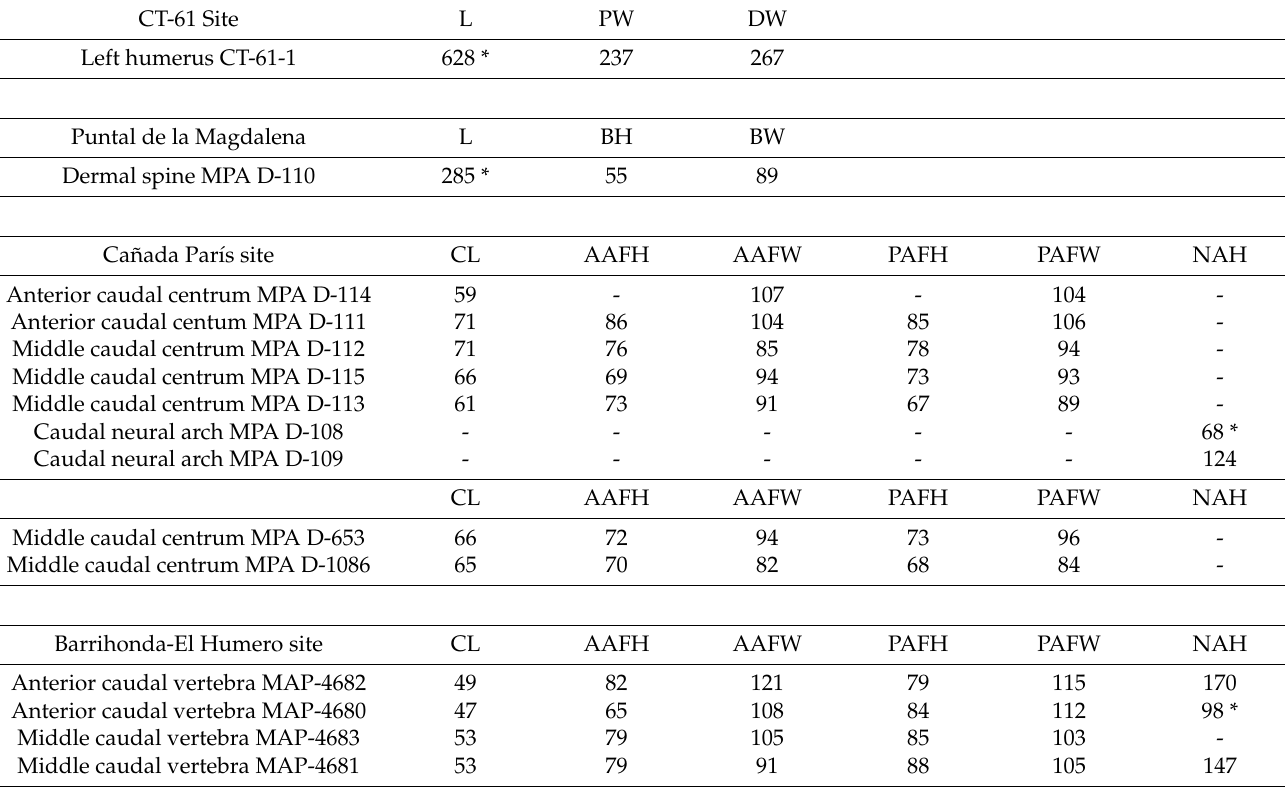
Table 1. Measurements (in mm) of the elements of the stegosaur specimens from the Villar del Arzobispo Formation studied in this